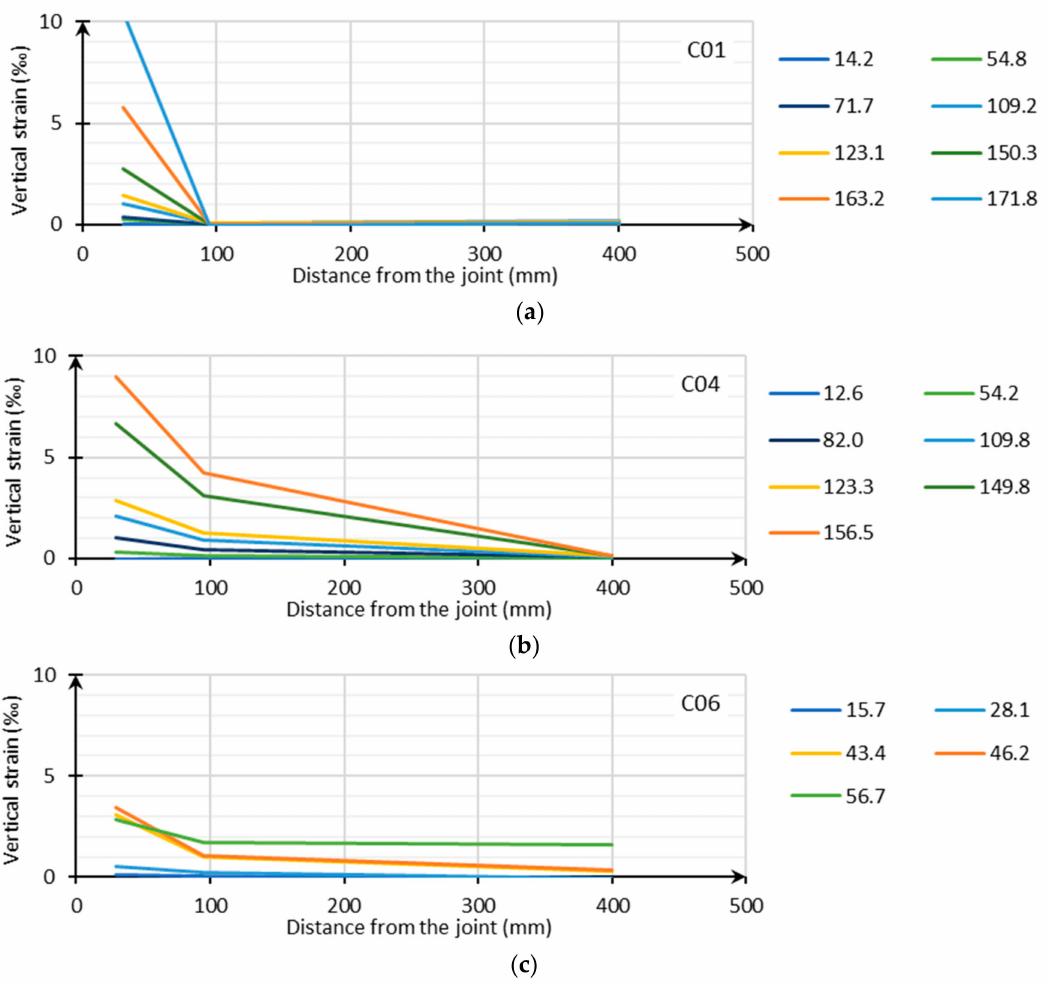
Figure 8. Vertical strains near the joint: ( a ) C01with lattice girder at 95 mm; ( b ) C04 with lattice girder at 400 mm; ( c ) C06 with Plexi interface and lattice girder at 95